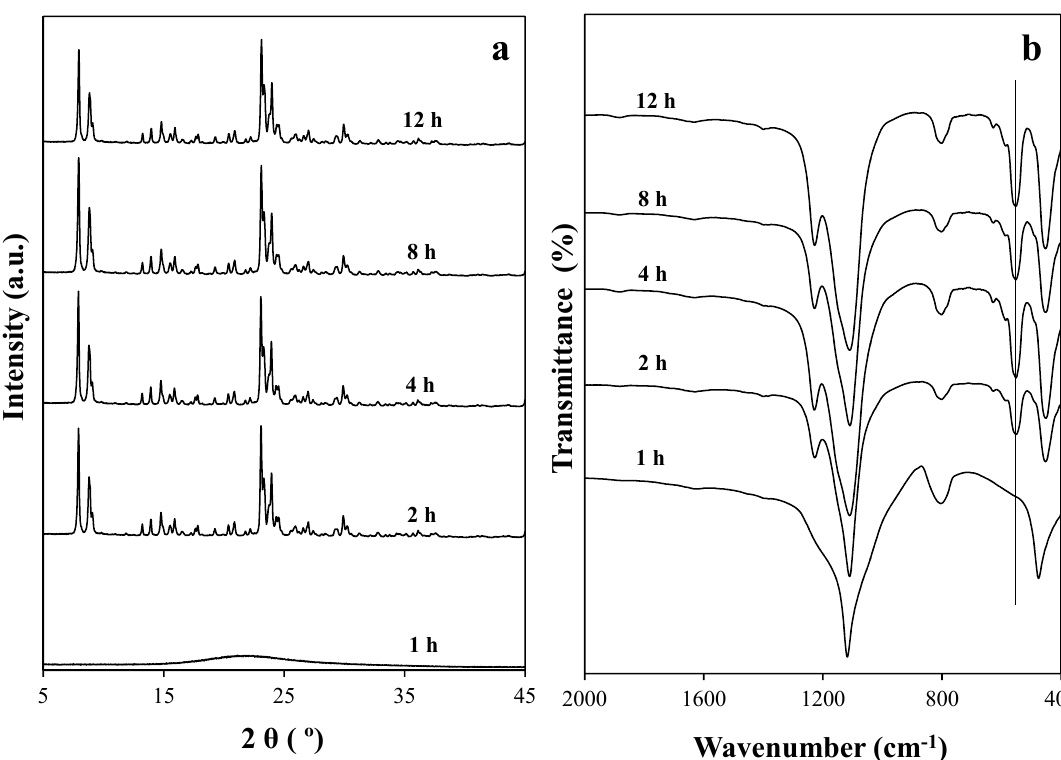
Figure 5. The XRD pattern ( a ) and FTIR ( b ) of silicalite-1 synthesized from silica spheres of 300 nm.